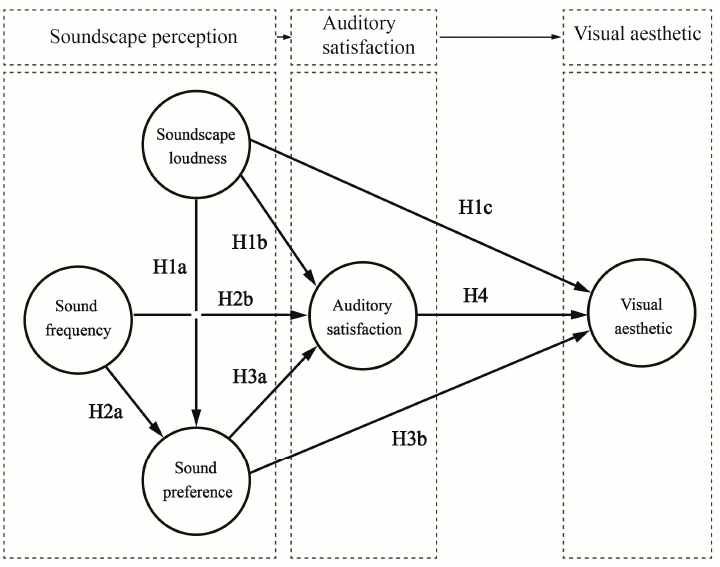
Figure 2. Theoretical hypotheses model.